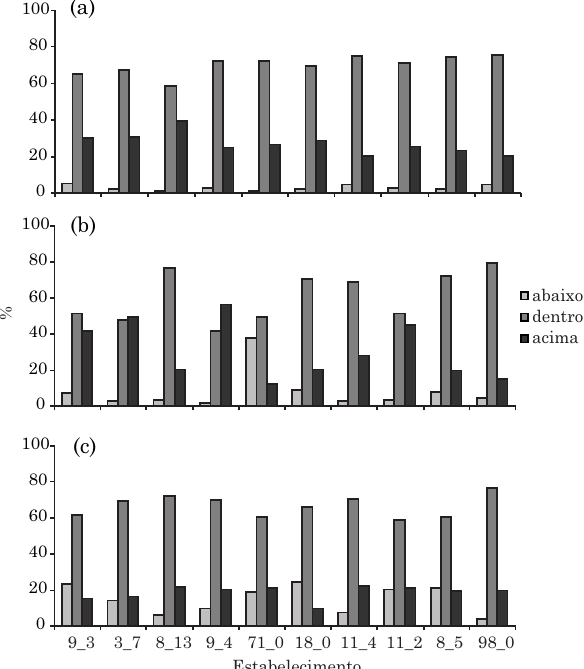
Figura 1. Frequências das conformidades das análises fiscais, por estabelecimento, para nitrogênio (a), fósforo (b) e potássio (c).